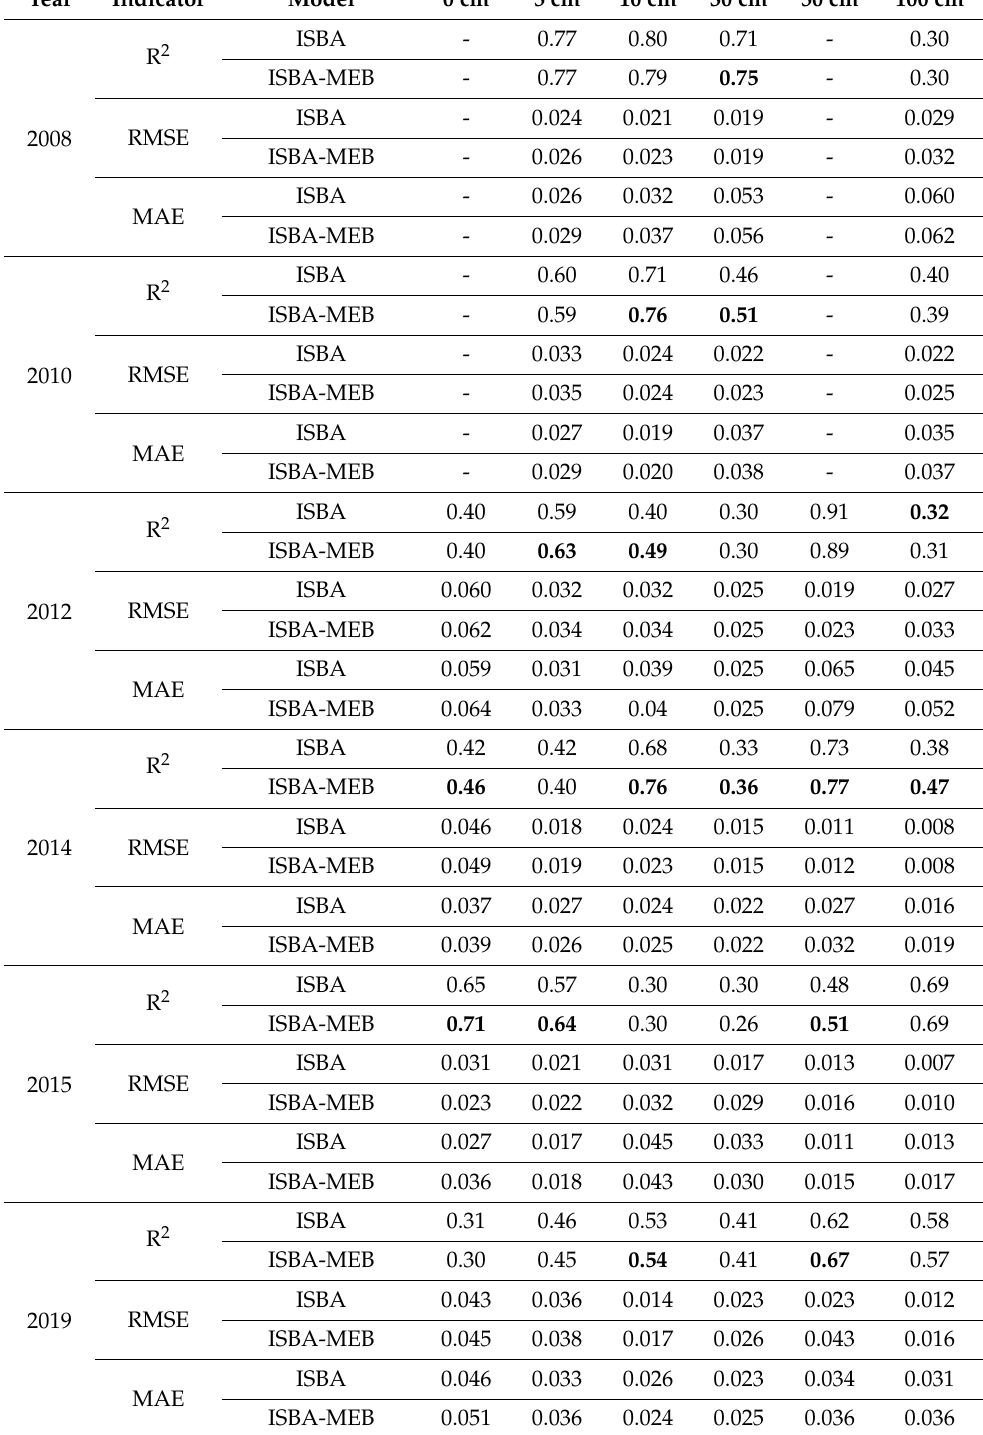
Table 5. Statistical metrics of the comparison between the observed soil moisture and the estimates of ISBA and ISBA-MEB, over the six maize years. The units of RMSE and MAE are in mm and in bold fonts are cases when ISBA-MEB had better metrics (R 2